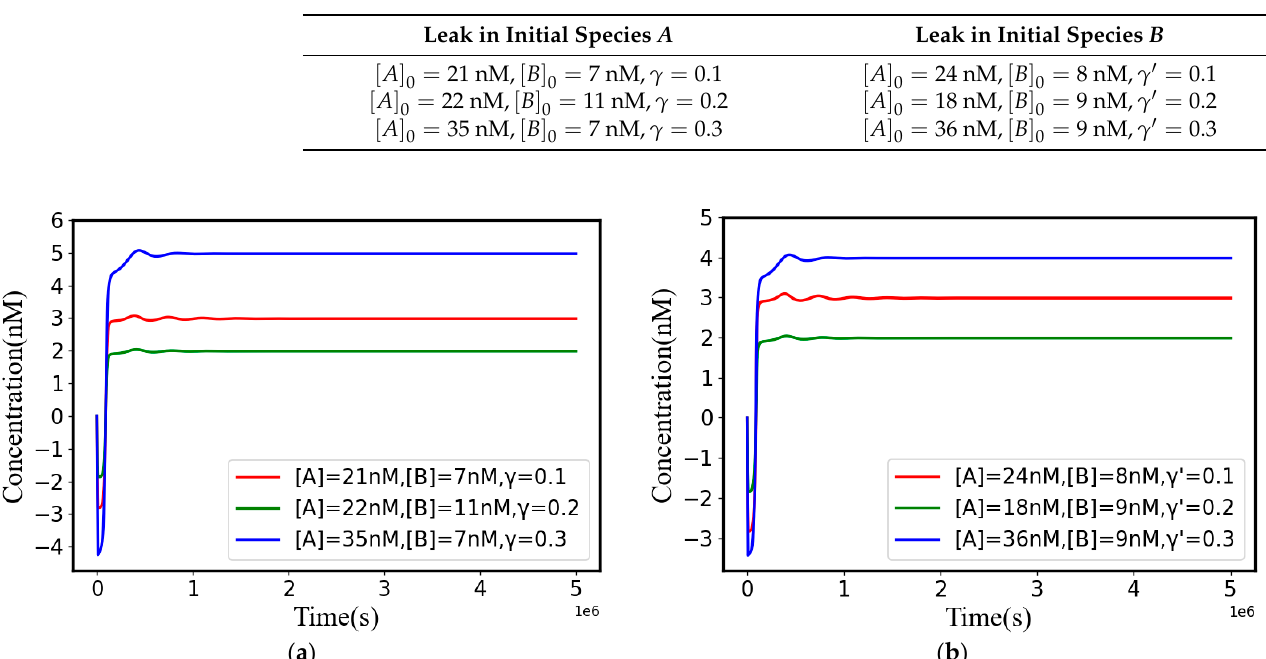
Figure 15. Calculation results of 2DOF IMC-PID division gate control system: ( a ) leak reaction at the divisor; ( b ) leak reaction at the dividend.